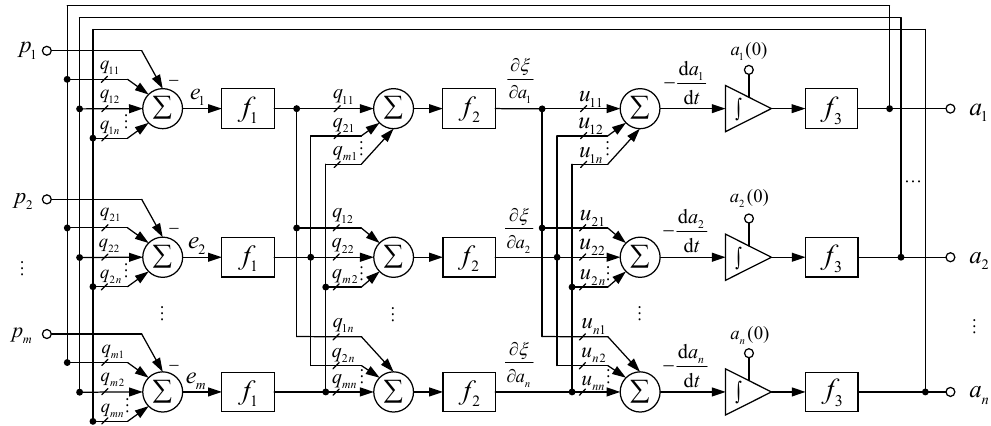
Figure 2. Scheme framework of improved artificial neural network based on direct least squares regression.